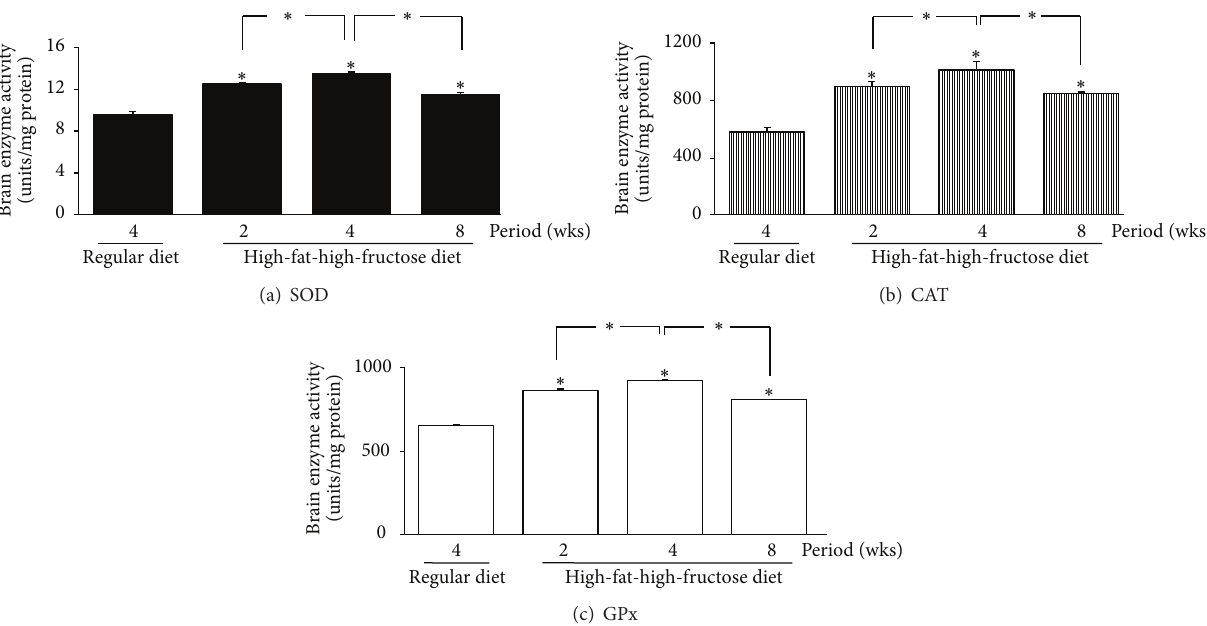
Figure 7: Effects of a high-fat, high-fructose diet on the SOD, CAT, and GPx enzymatic activity in the mouse brains. Mice were fed a commercial standard diet for 4 weeks, and a high-fat, high-fructose diet (HFFD) was administered intragastrically for 2, 4, or 8 weeks. The mice were sacrificed 24 h after the last treatment, and their brains were immediately excised to determine the SOD, CAT, and GPx enzyme activities. The data are presented as the mean ± SD ( 𝑛 = 5 ). Significant differences were determined using a one-way analysis of variance (ANOVA) followed by Tukey’s post hoc test. ∗ 𝑝 < 0.05 versus the regular diet